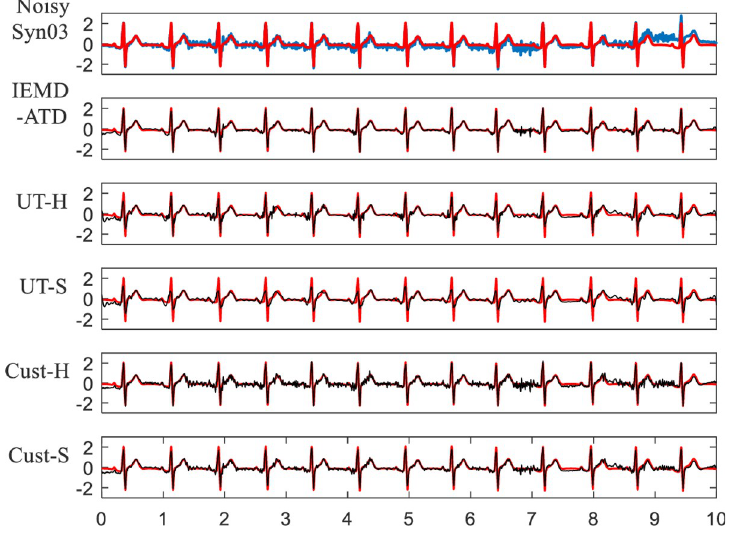
Fig 9. Waveforms of denoised ECGs for Syn03 with EMG noise at 5 dB in the 5 denoising